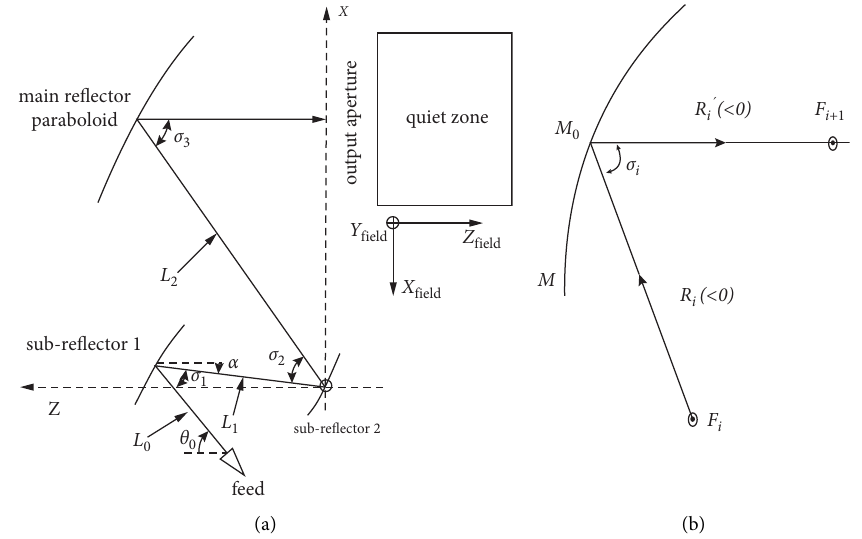
Figure 2: (a) Schematic diagram of geometric structure and design parameters of a tri-refector CATR. (b) Defnition of focal length in each refector.